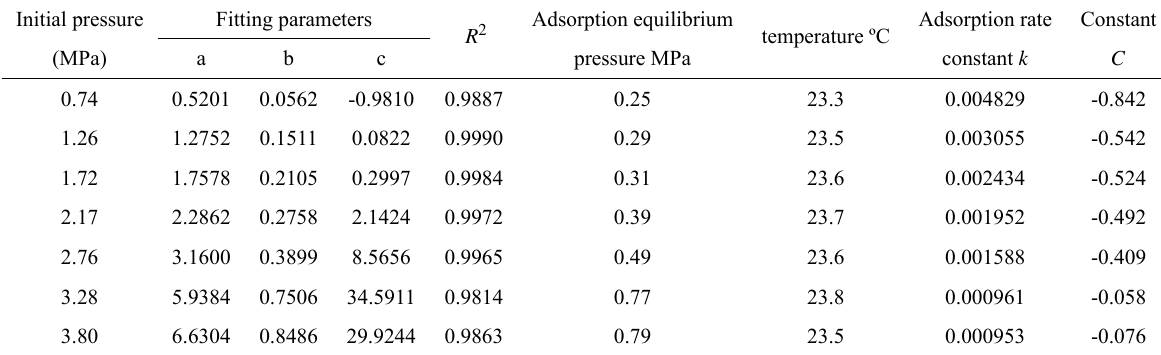
Adsorption rate constants for coal with 1.871% moisture